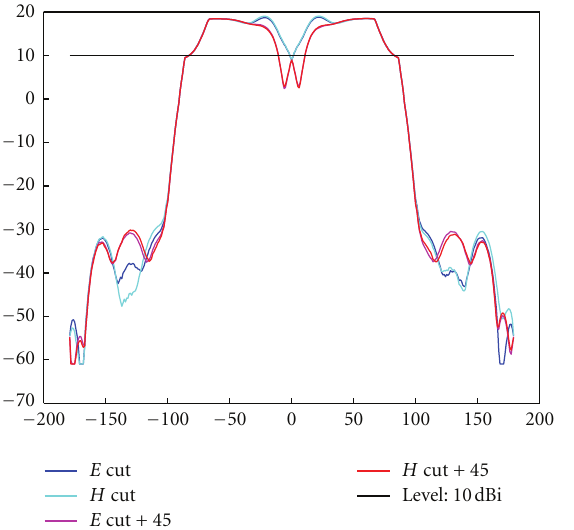
Figure 9: Principal-plane cuts of the array radiation